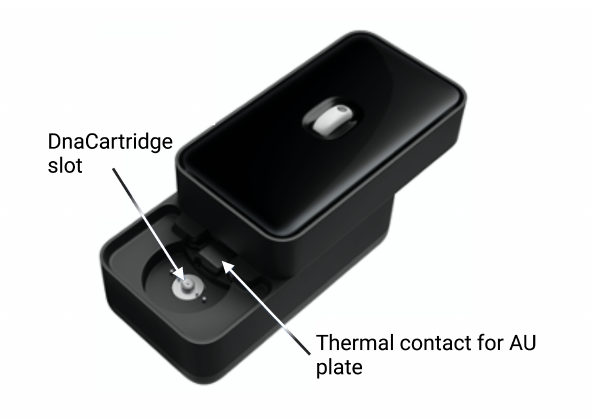
Figure 5. Sample preparation unit (SPU) and amplification unit (AU). In the SPU, the empty com- partments are used to collect waste or for additional buffers depending on the protocol. In the AU, all wells contain primers and several wells are used for the standards. Reprinted/adapted with permission from Ref. [12]. 2020, the Authors.